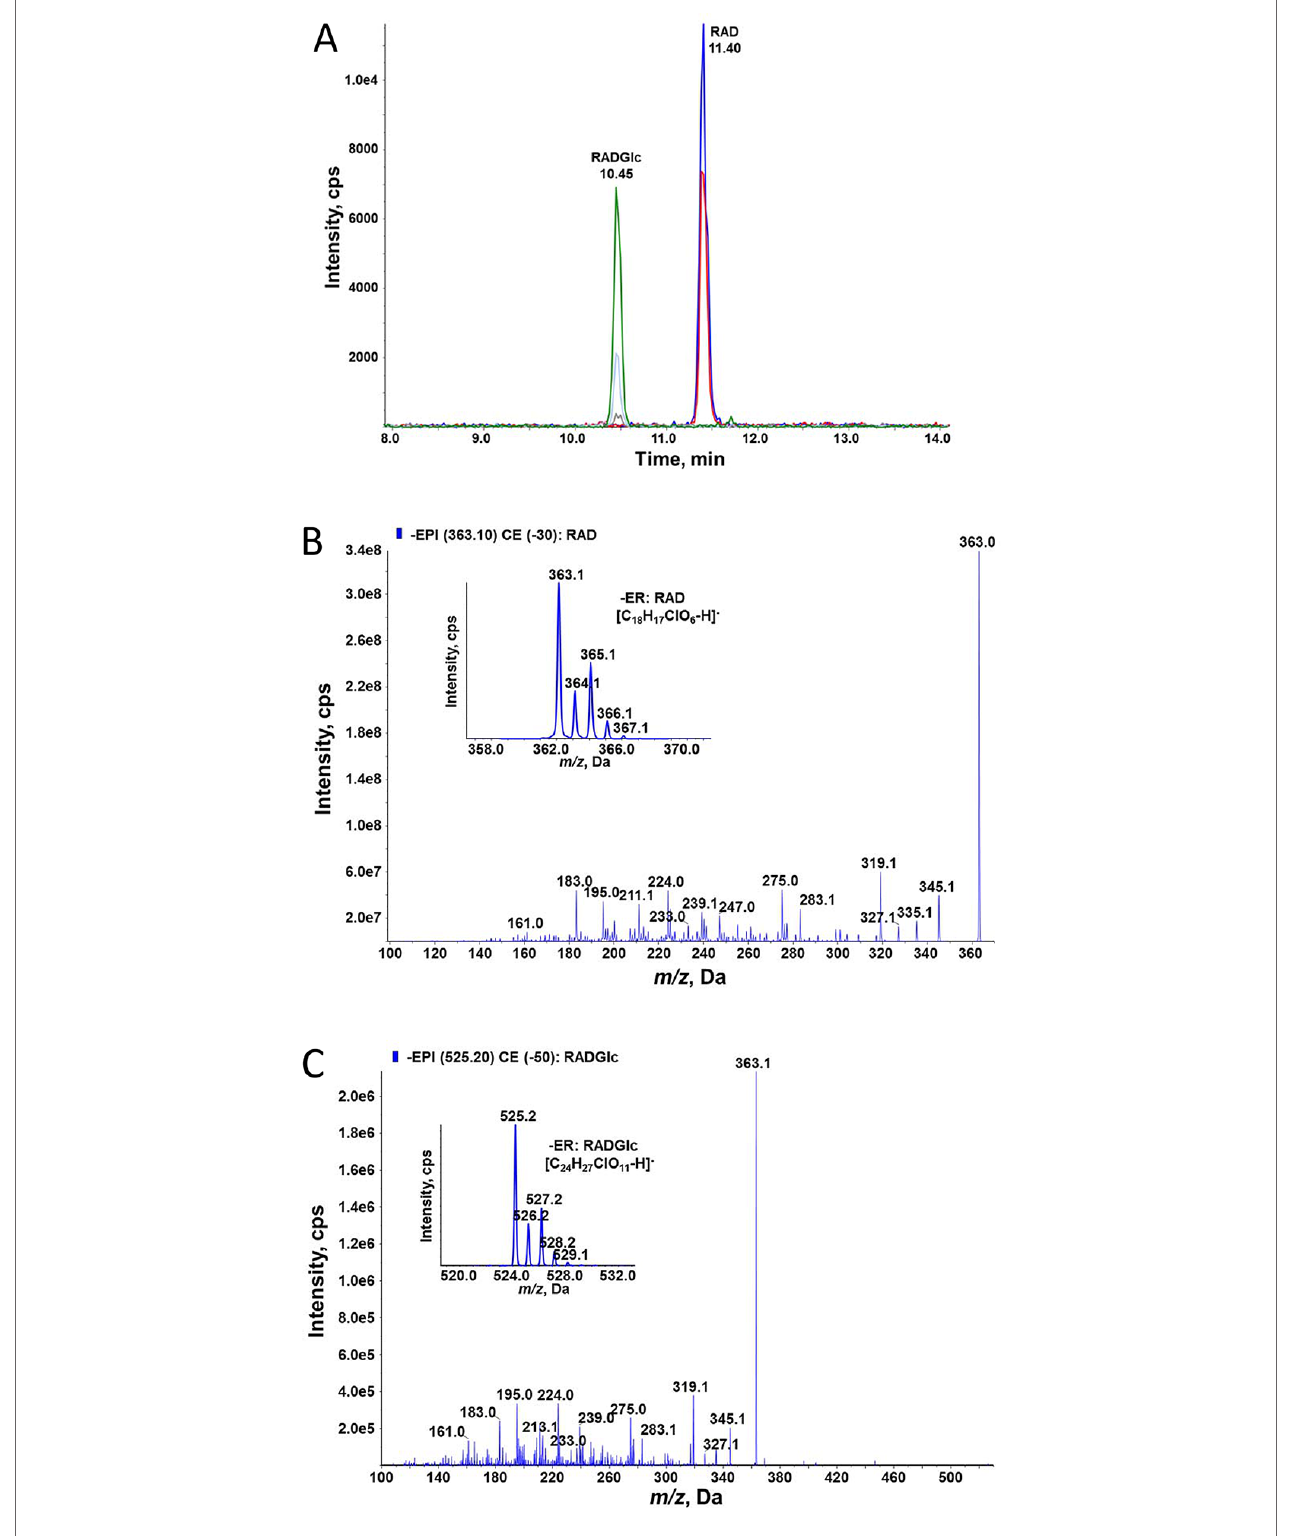
FIGURE 6 | High-performance liquid chromatographic–tandem mass spectrometric (HPLC–MS/MS) determination of RAD and radicicol-glucoside (RADGlc expressing UGT73C6 treated with RAD. (A) HPLC–MS/MS analysis in selective reaction monitoring mode of a culture filtrate of yeast. (B) Enhanced product ion (EPI) MS/MS spectrum of RAD at 30 eV collision energy; the inlay shows the MS spectrum of the deprotonated ions. (C) EPI MS/MS spectrum of RADGlc at 50 eV collision energy; the inlay shows the MS spectrum of the deprotonated